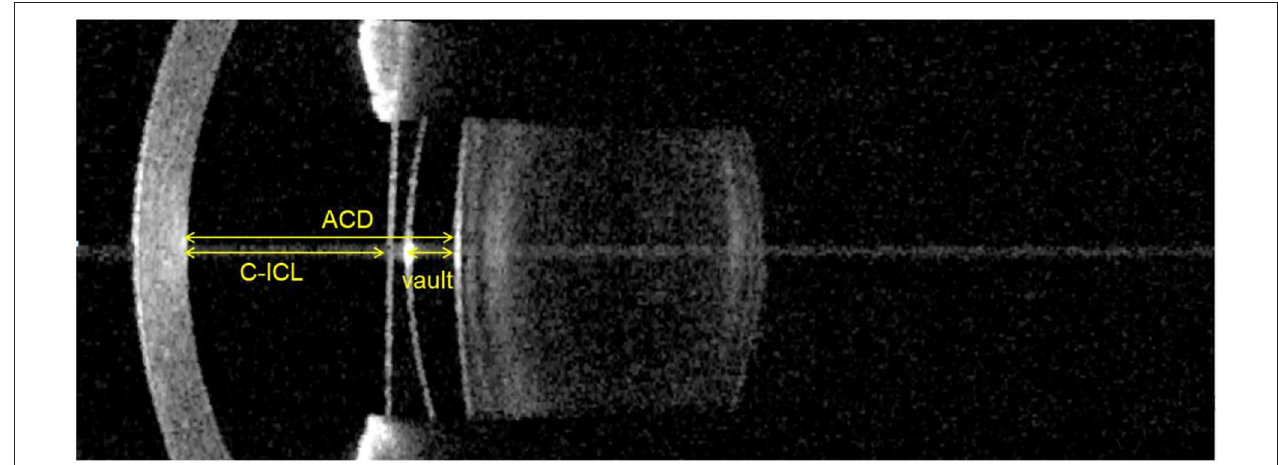
FIGURE 1 | Vault, C-ICL, and ACD measurements made using the IOL Master 700. Vault: Distance between the anterior surface of the crystalline lens and the posterior surface of the ICL. C-ICL: Distance between the corneal endothelium and anterior surface of the ICL. ACD: Distance between the corneal endothelium and the anterior surface of the crystalline